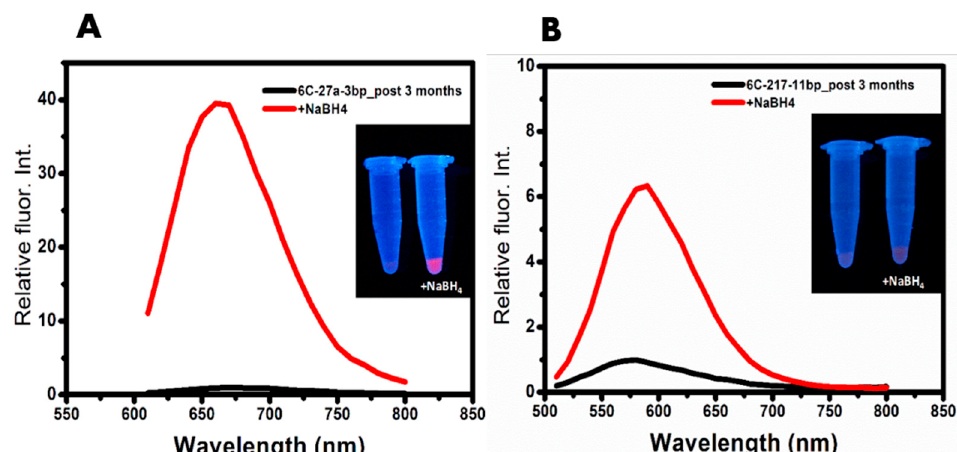
Figure 6. ( A ) Emission wavelength of DNA 6C-27a-3bp with Ex / Em wavelength 580 / 660 nm. ( B ) Emission wavelength of DNA 6C-217-11bp with Ex / Em wavelength 480 / 590 nm. Insets show the eppendorf tube images under UV (Ex 365 nm) illumination before and post NaBH 4 additions. Black line refers to fluorescence of DNA / AgNCs post 3 months of incubation, while red line refers to re-reduced DNA / AgNCs fluorescence with 250 µ M NaBH 4 .